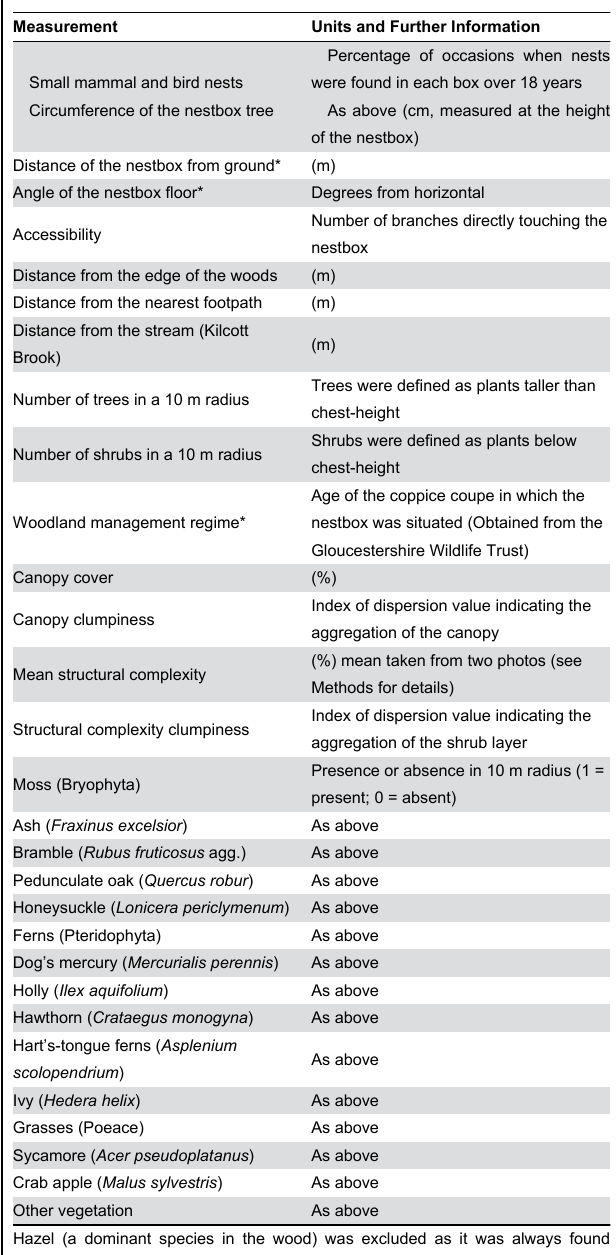
Measurement Units and Further